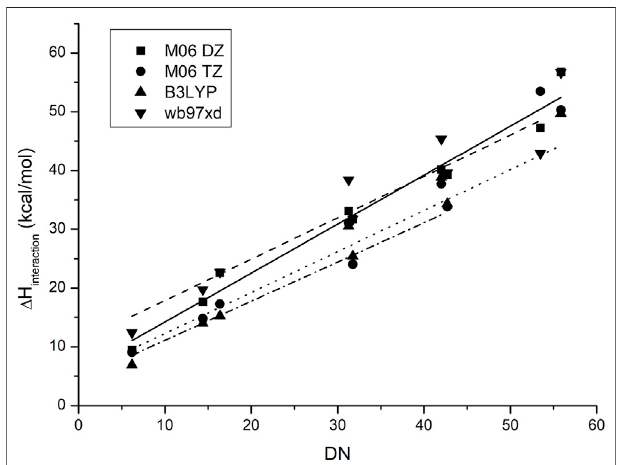
FIGURE 4 | Correlation between the experimental values of the donor numbers and the calculated binding enthalpies between antimony pentachloride and the corresponding ionic liquid when the functional and basis set are changed.